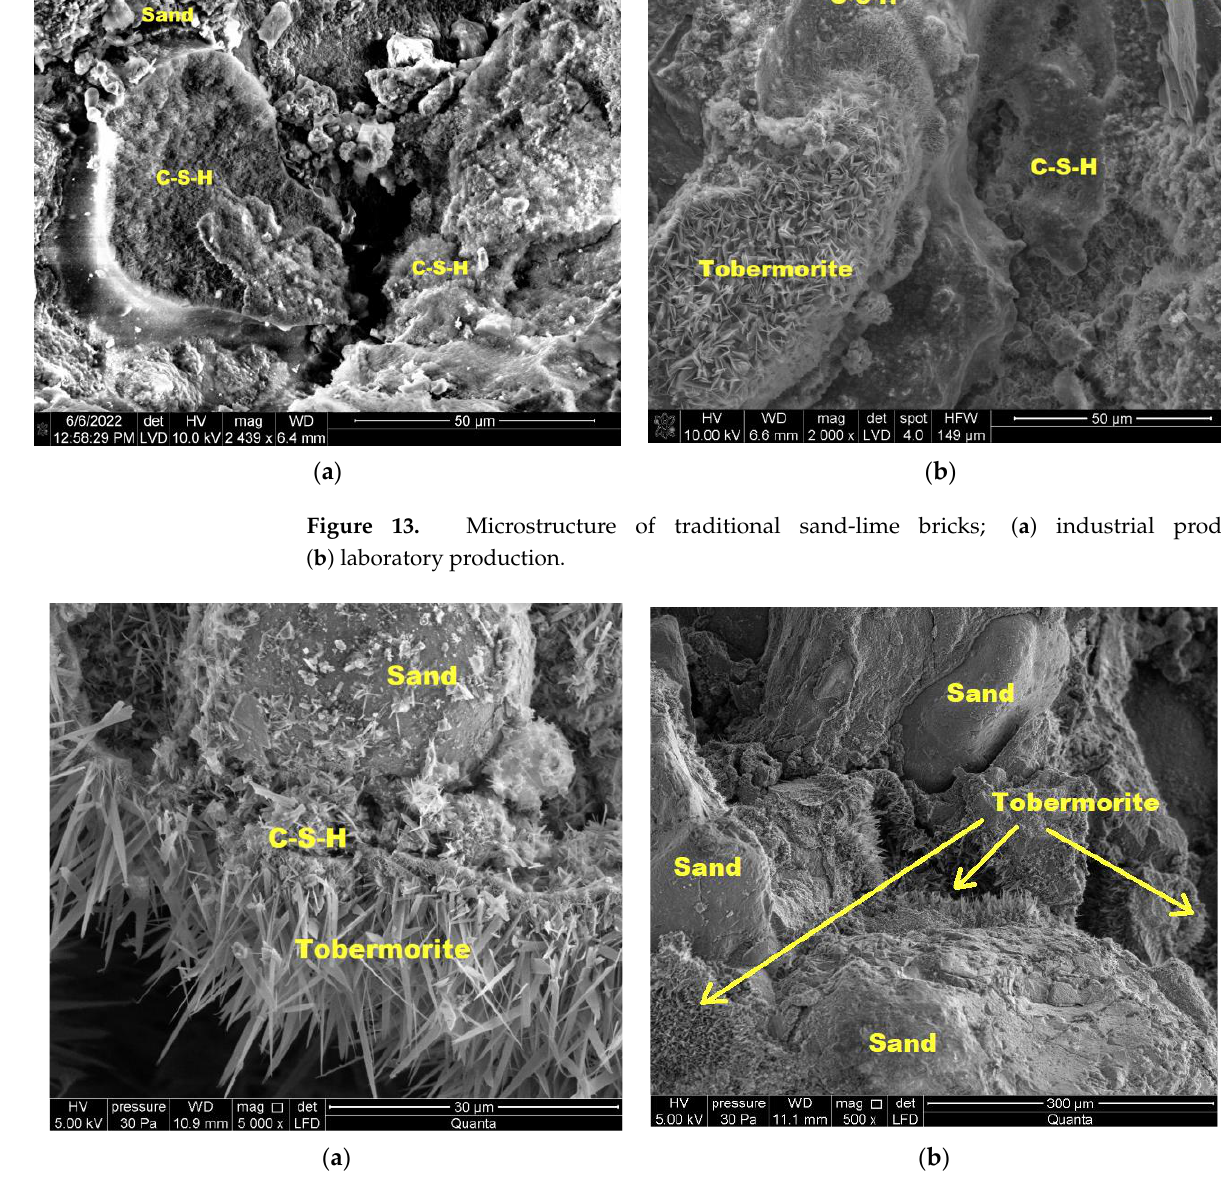
Figure 14. Microstructure of a BP10-W10 sample: ( a ) mag 5000 × ; ( b ) mag 500 ×